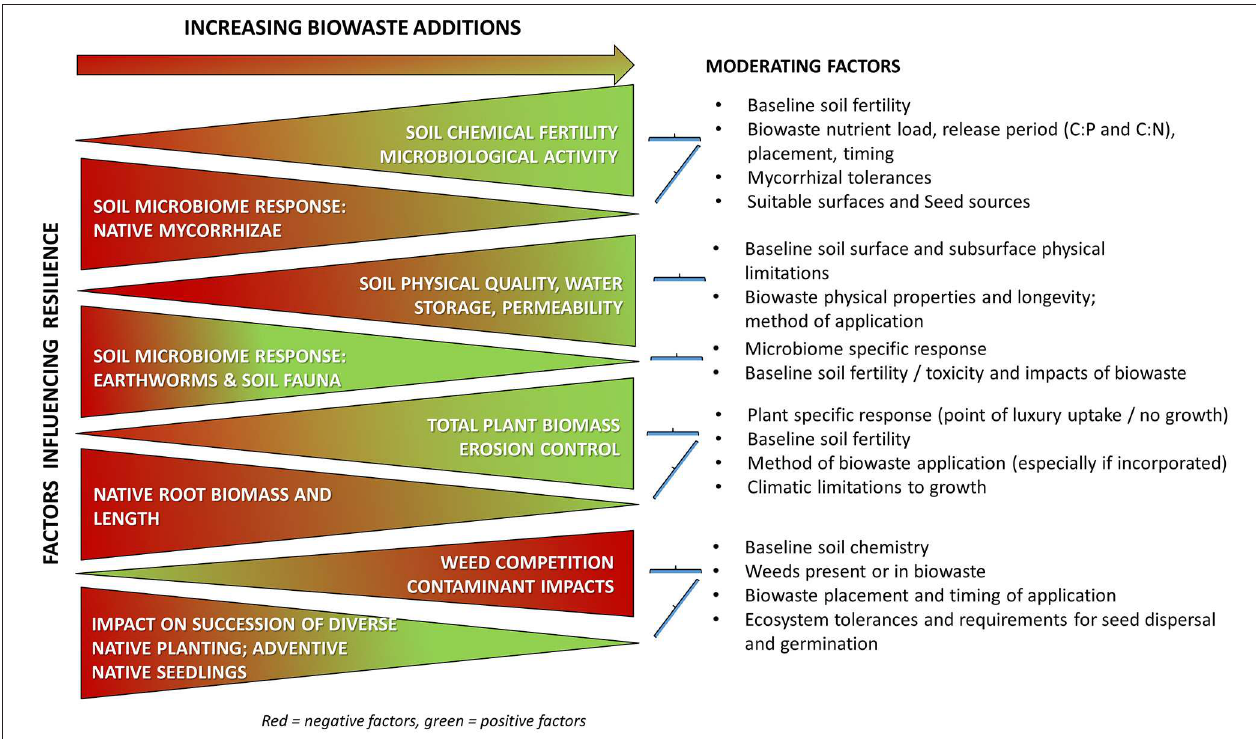
FIGURE 1 | Summary of generalized effects of biowastes on main factors that determine success of restoration/native ecosystem restoration in New Zealand. The review discusses the evidence and moderating factors (right hand side) that influence the extent and type of response. Resilience is critical and influenced by all these